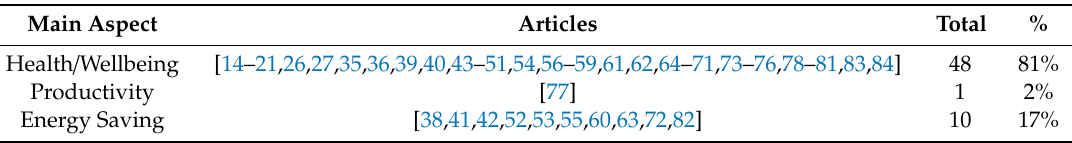
Table 7. Division of the main aspects.